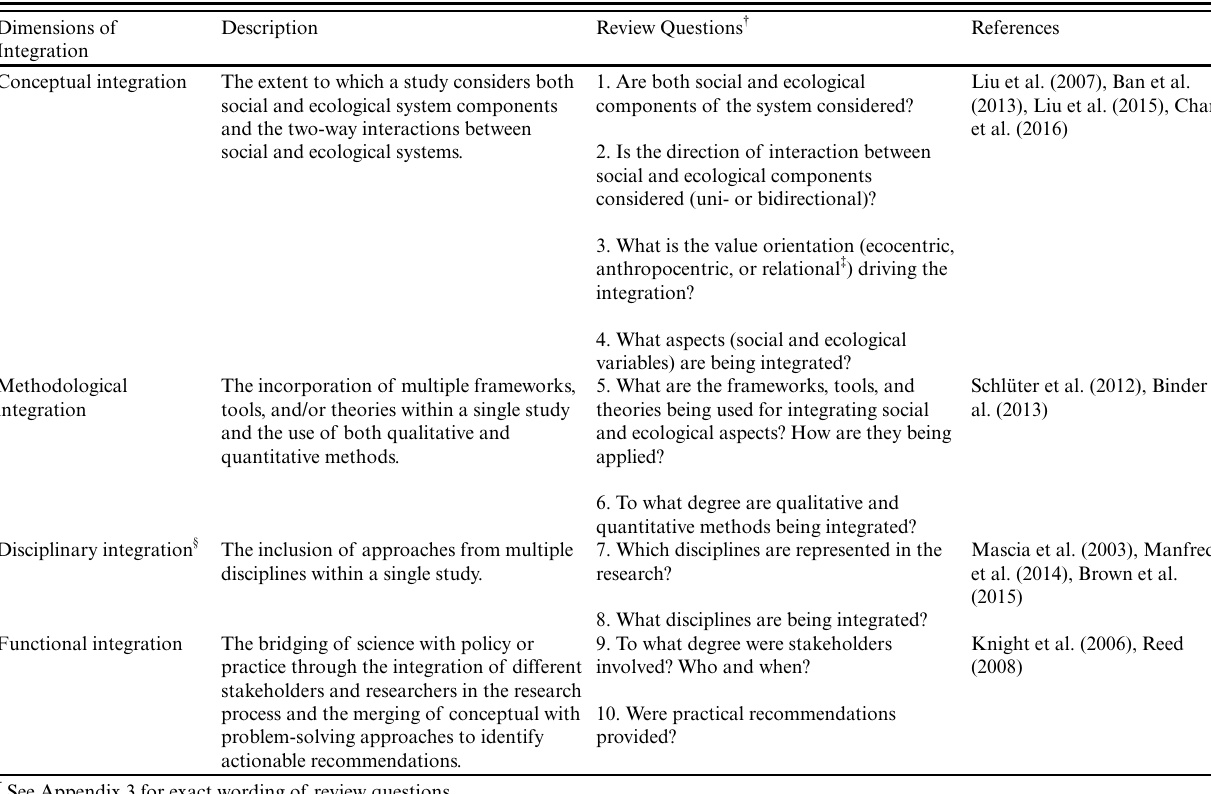
Table 1 . The four dimensions of social-ecological integration considered in this study, with descriptions, specific research questions, and references used to illustrate relevance of different